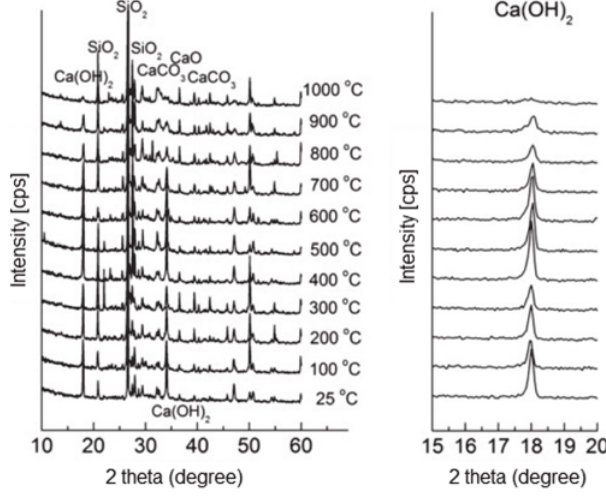
Diffractograms of cement paste heated at different temperatures (adapted